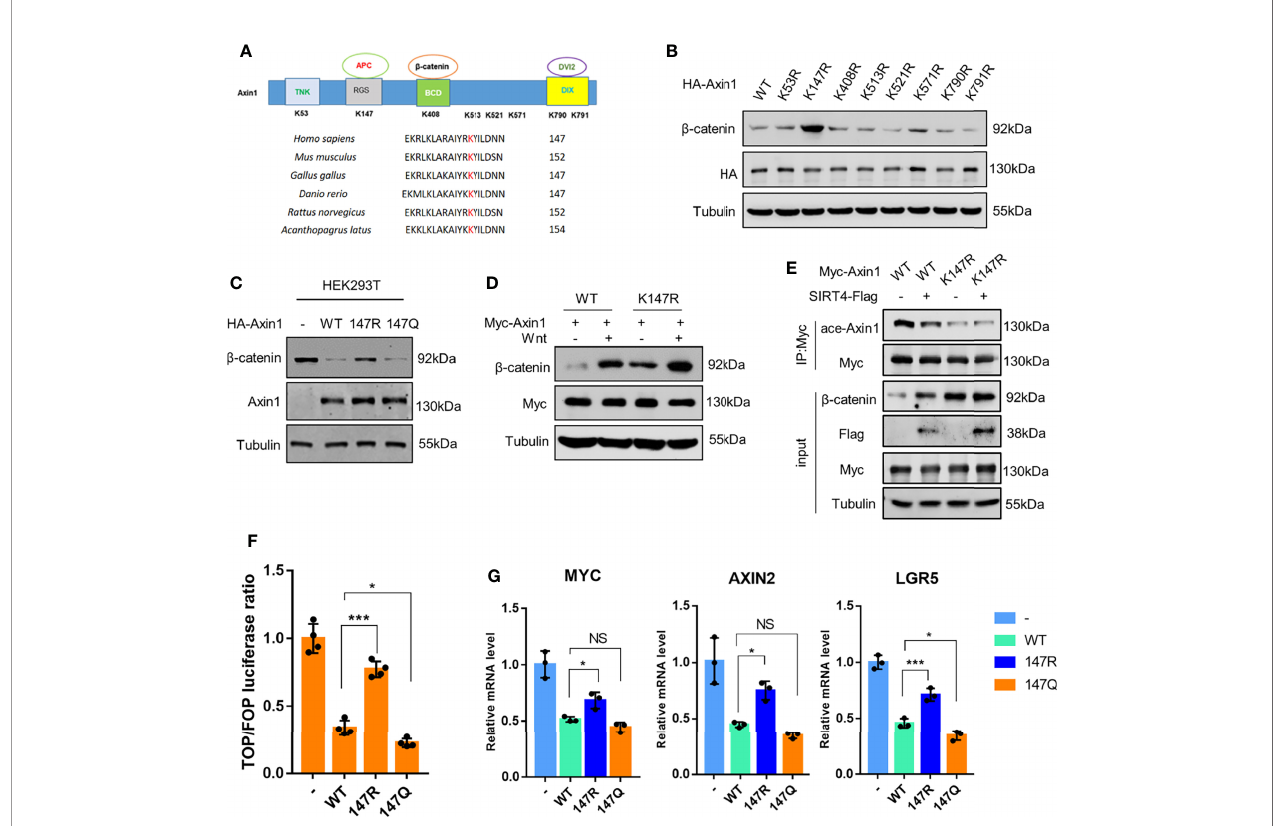
FIGURE 4 | SIRT4-regulated deacetylation of the Axin1-K147 residue iscrucial for the activation of the canonical Wnt/ b -catenin signalingpathway. (A) Mass spectrometry analysisof thepotential acetylation sites of Axin1. Multiple sequence alignment amongspecies showed a conserved Lys147 residue in Axin1. (B) HA-Axin1 mutants (K53R, K147R, K408R, K513R, K521R, K571R, K790R, K791R)wereoverexpressedin HEK293T cells respectively,the wholecelllysates were analyzed bywestern blot with the indicatedantibodies. (C) HEK293T cells were transfectedwith HA-Axin1-WT, HA-Axin1-K147R or HA-Axin1-K147Q.The whole celllysates were analyzed bywesternblot with the indicated antibodies. (D) HEK293T cells were transfected with Myc-Axin1-WT or Myc-Axin1-K147R and then treated with Wnt3a conditionedmedium for 30 min. The wholecelllysates were analyzed by western blot with theindicated antibodies. (E) HEK293T cells were cotransfected with Myc-Axin1/Myc-Axin1-K147R andSIRT4- Flag as indicated.The wholecelllysates were collected andanalyzedby western blot with the indicated antibodies as input, Myc-Axin1was immunoprecipitated with anti- Myc and the acetylation levels were analyzedby western blot. (F) Dual-luciferase reporter assay ofTOP/FOP activity inHEK293T cellstransfectedwith HA-Axin1-WT, HA- Axin1-K147R orHA-Axin1-K147Q (n=4; error barsrepresent ± SD, *p<0.05, ***P<0.0001; ordinary one-way ANOVA with multiplecomparisonsfollowed byHolm-Sidak ’ s test). (G) HEK293T cells were transfectedwith HA-Axin1-WT, HA-Axin1-K147R andHA-Axin1-K147Q respectively. Total RNA was extracted with TRIzol and the mRNA levelsof b -catenintarget genes (AXIN2, LGR5 and MYC) were analyzed with RT-qPCR (n = 3; errorbars represent ± SD, *p<0.05, ***p<0.001; n=0.3>0.05 NS, no signi fi cant; ordinaryone-way ANOVA with multiplecomparisons followedby Holm-Sidak ’ s